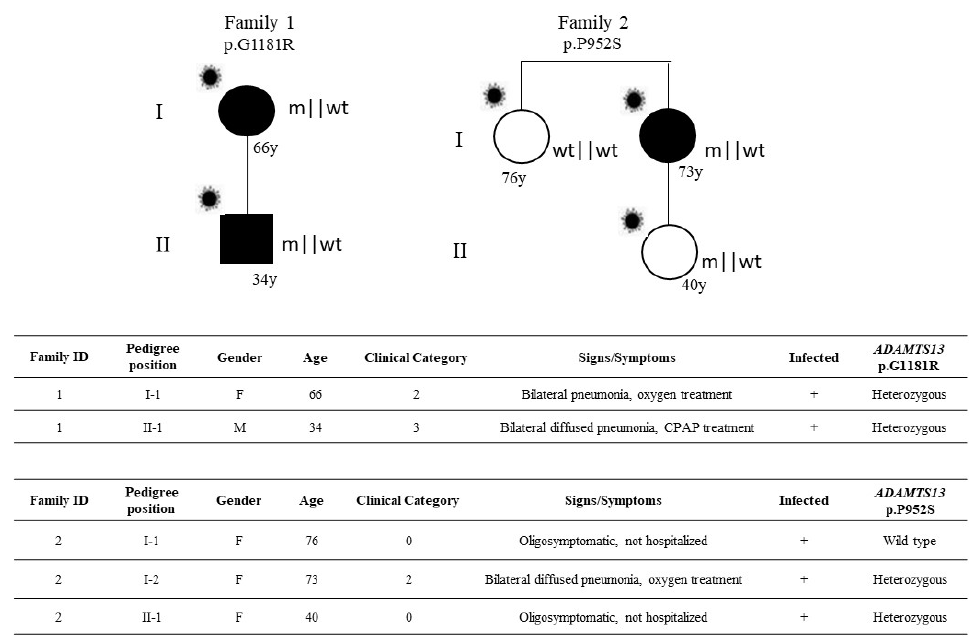
Figure 2. Segregation analysis. Pedigree ( upper panel ) and respective segregation of ADAMTS13 variant and COVID-19 status ( lower panel ) are shown. Squares represent male family members; circles represent females. A virus cartoon close to the individual symbol indicates individuals infected by SARS-CoV-2 ( ). The inheritance pattern appears that of an autosomal dominant disor- der conditioned by SARS-CoV-2 infection, sex, and